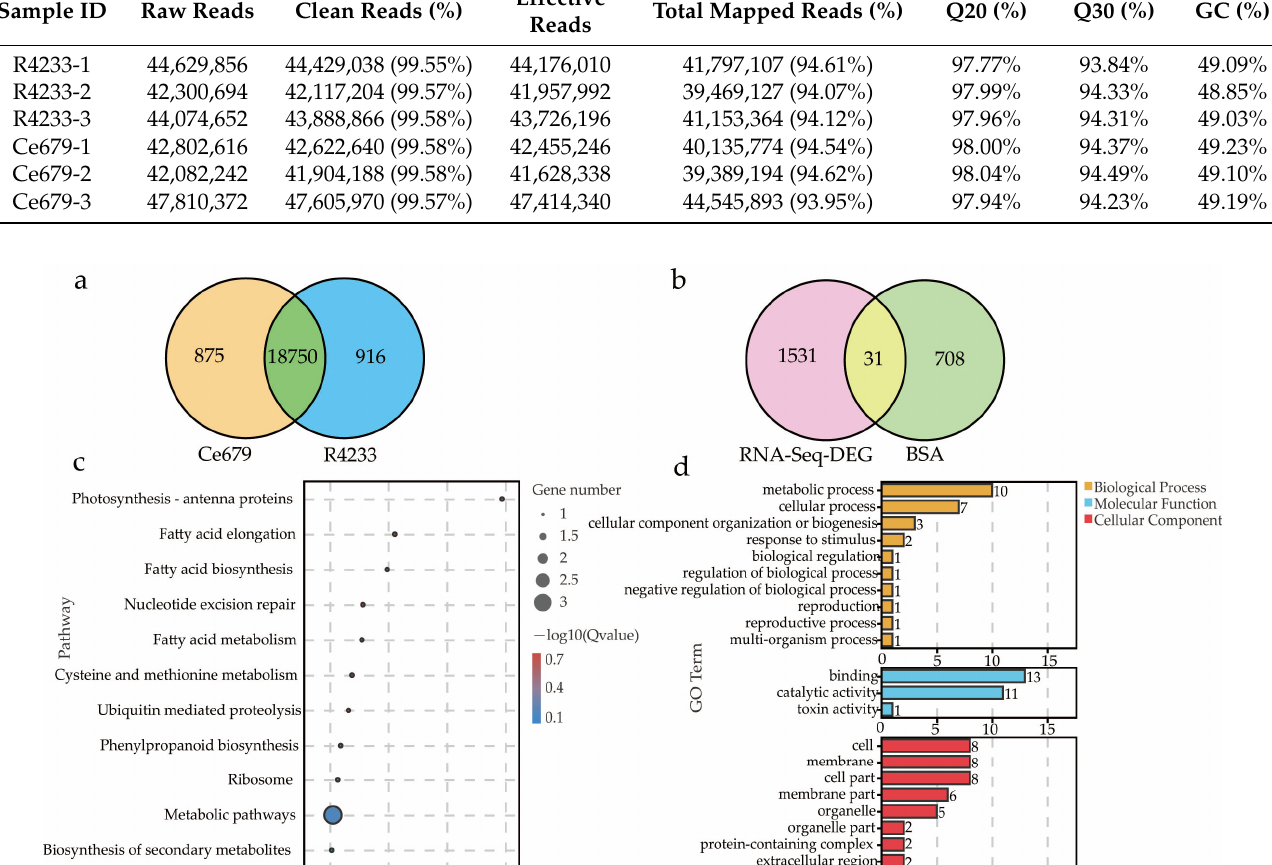
Figure 5. Gene expression pattern and DEGs analysis for GNPP in candidate intervals. ( a ), Venn diagram of expressed genes; ( b ), Venn diagram of BSA-Seq merged with RNA-seq; ( c ), KEGG pathway enrichment analysis; ( d ), GO classification.